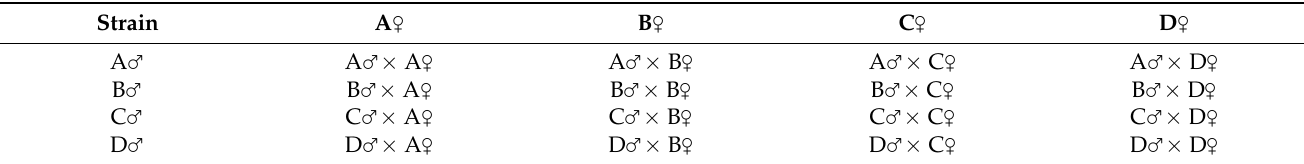
Table 1. Sixteen crossbred groups used in this